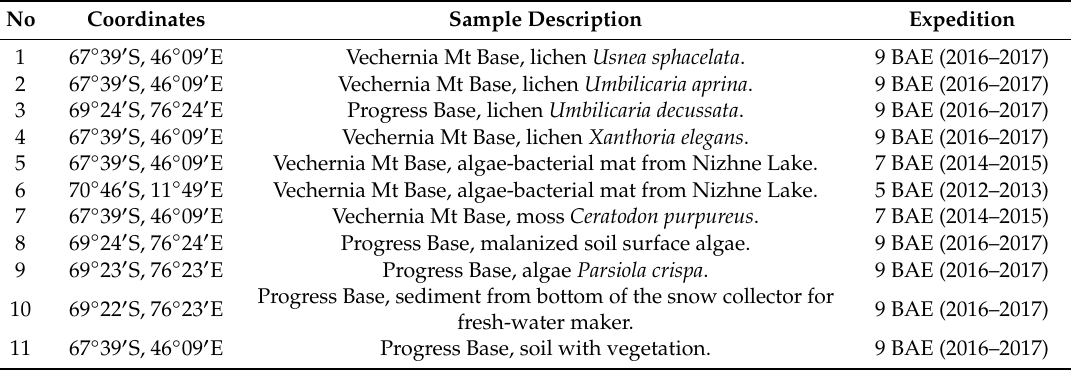
Table 1. Samples and